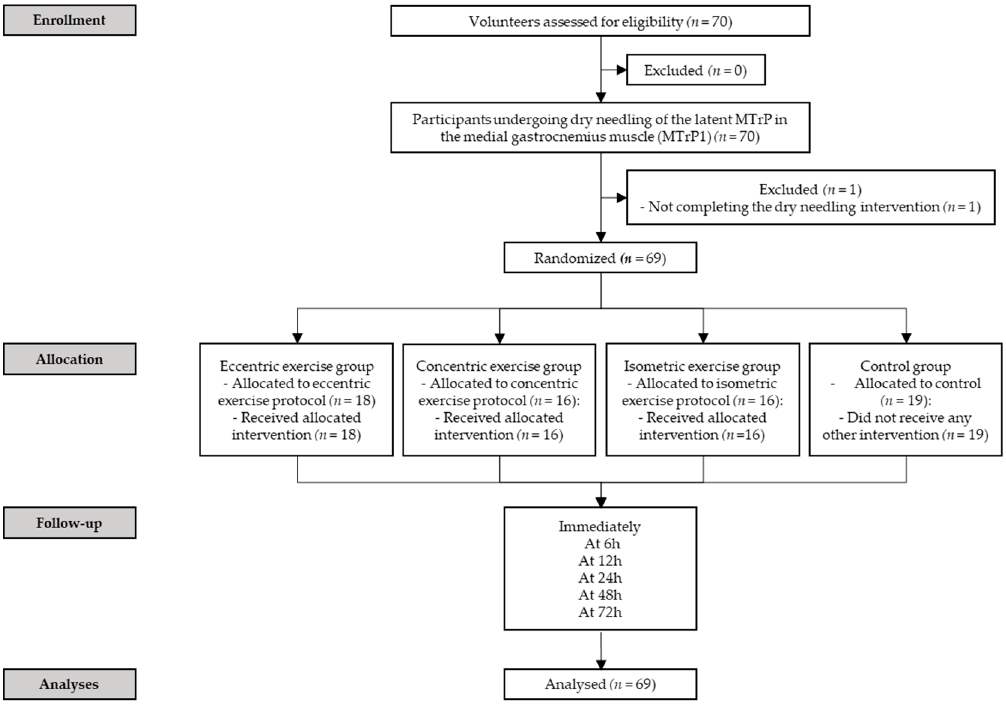
Figure 1. Flowchart of participants throughout the trial; MTrP (myofascial trigger point). No statistically significant differences were found between groups at baseline on almost all variables collected (Table